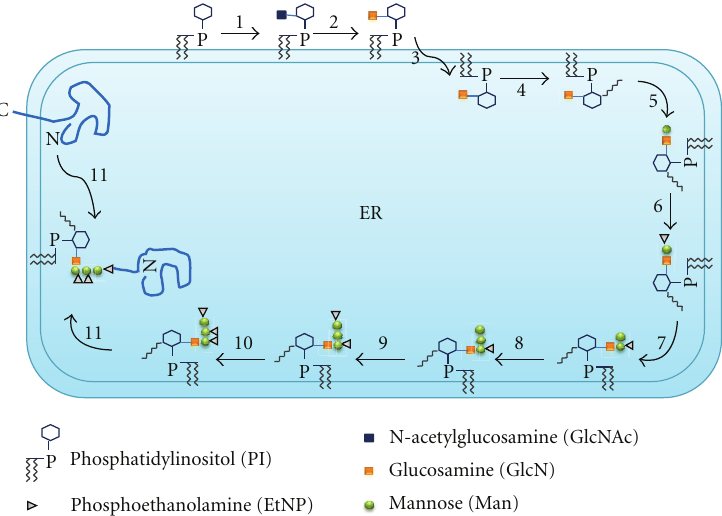
Figure 6: Schematic illustration of GPI biosynthesis in the ER of yeast and mammals. Biosynthesis of the GPI anchor begins at step 1; PI is glycosylated to generate GlcNAc-PI on the cytoplasmic face of the ER. GlcNAc-PI is then de-N-acetylated (step 2) to yield GlcN-PI. GlcN-PI is flipped (step 3) into the lumenal leaflet of the ER, where it is inositol acylated (step 4), inositol mannosylated, and modified by EtNP (steps 5–10). The EtNP-capped GPIs are attached (step 11) to ER-translocated proteins displaying a C-terminal GPI signal sequence. Step 11 is catalyzed by GPI